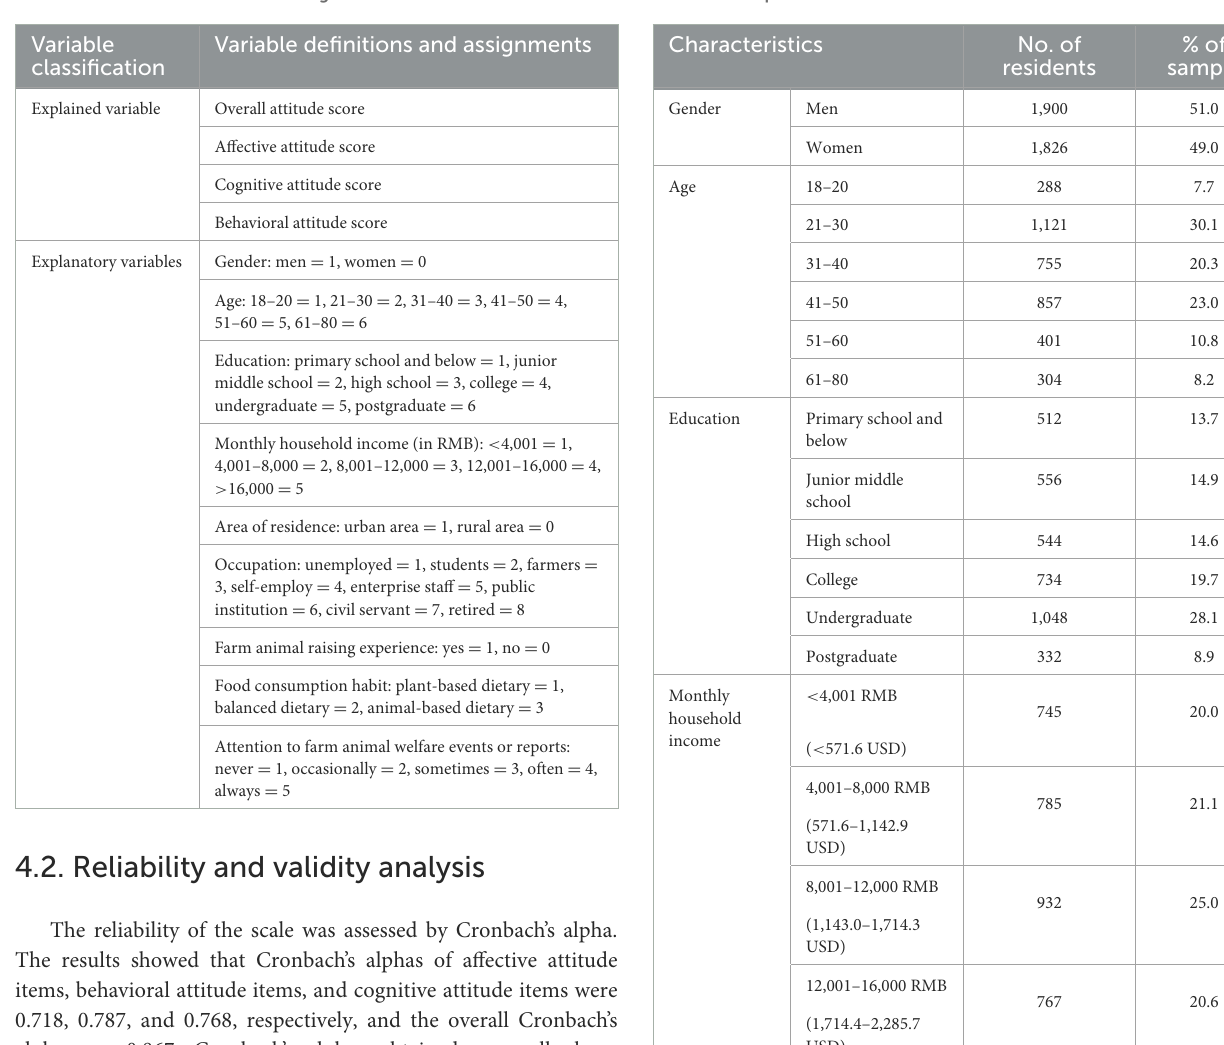
TABLE 2 Variable definitions and assignments. TABLE 3 Sample